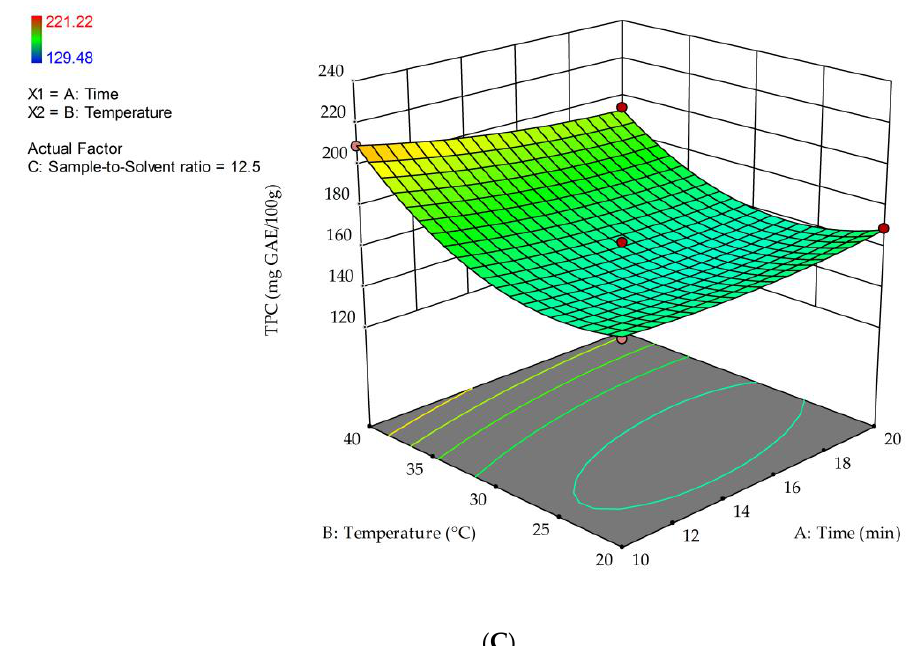
Figure 2. 3D response surfaces of TPC as a function of the interactions between extraction temperature and sample-to-solvent ratio ( A ); extraction time and sample-to-solvent ratio ( B ); extraction temperature and extraction time ( C ).